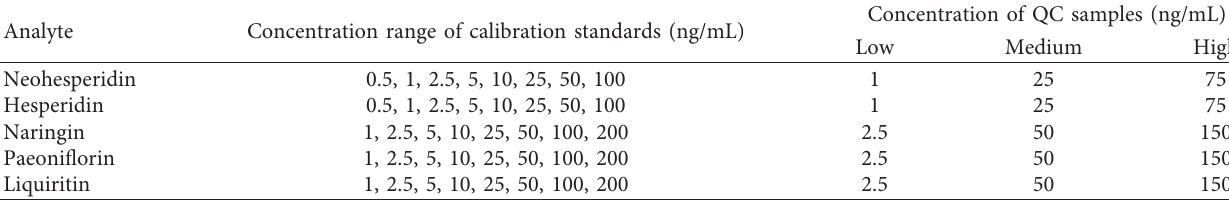
Table 4: The specific concentration of calibration curve standards and QC